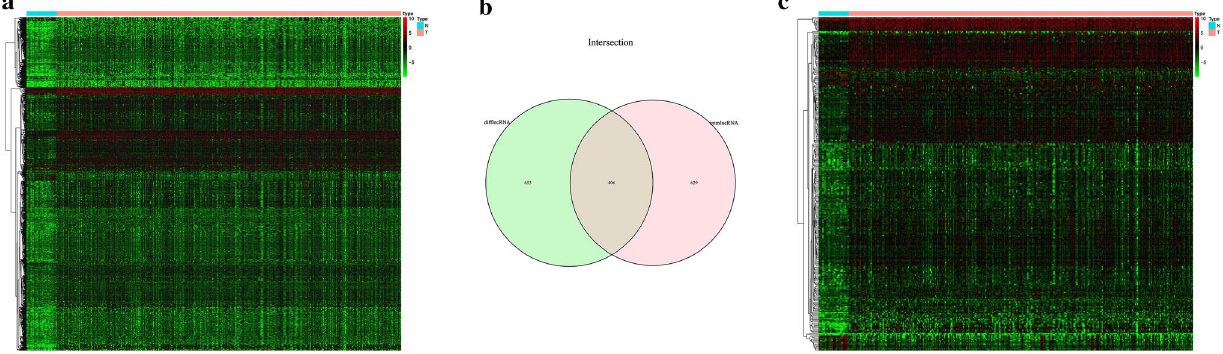
Fig. 2 Differentially expressed immune-related lncRNAs. a Heatmap of differentially expressed lncRNAs in GAC. b Venn diagram of over- lapping lncRNAs between immune-related lncRNAs and differentially expressed lncRNAs. c Heatmap of differentially expressed immune- related lncRNAs in